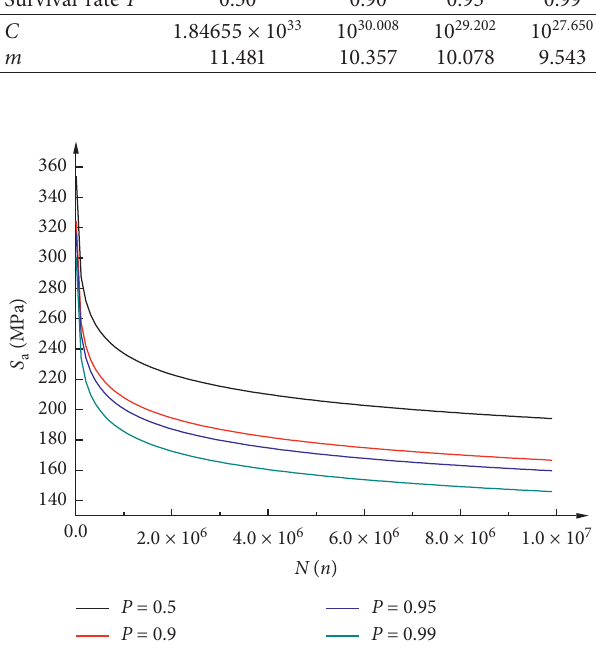
Table 1: P-S-N parameter estimation results of Q345 steel. Survival rate P